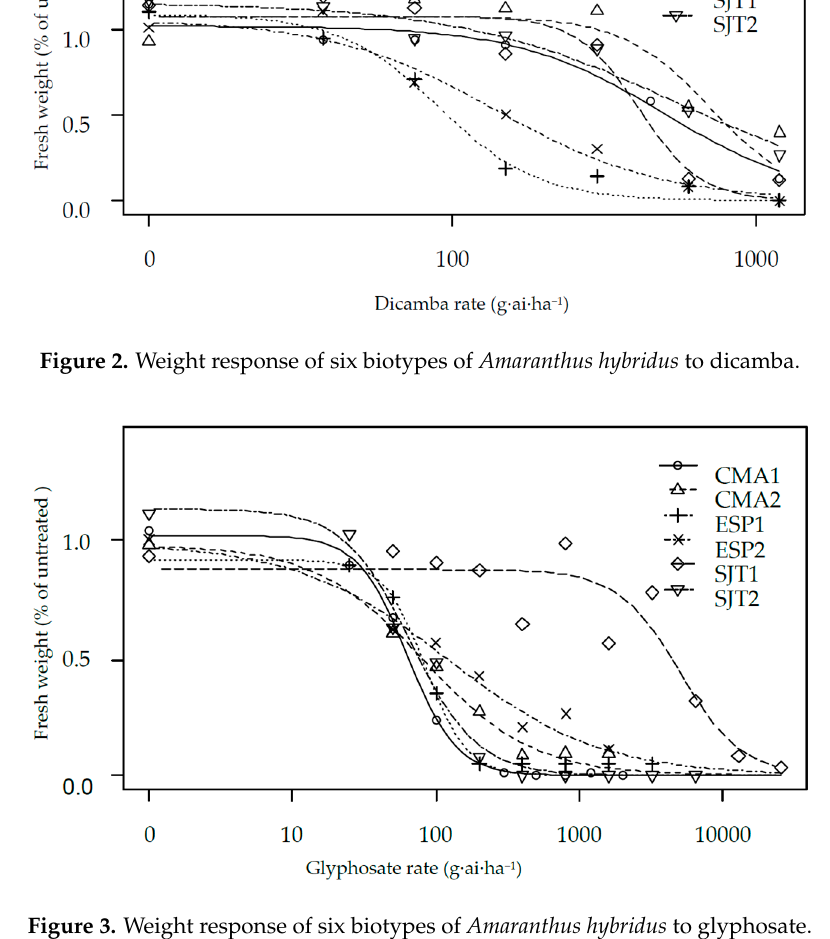
Figure 3. Weight response of six biotypes of Amaranthus hybridus to glyphosate.